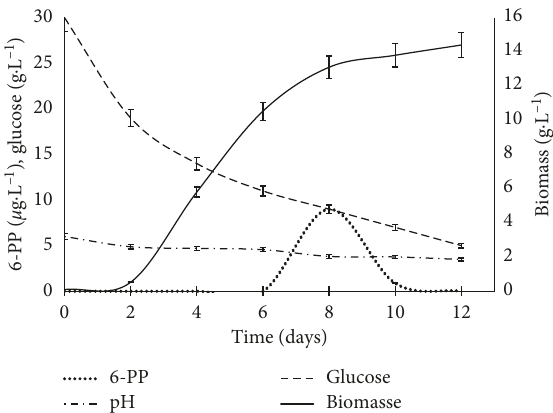
Figure 1: Evolution of 6-PP, glucose, and biomass in the liquid medium with Trichoderma asperellum G7.